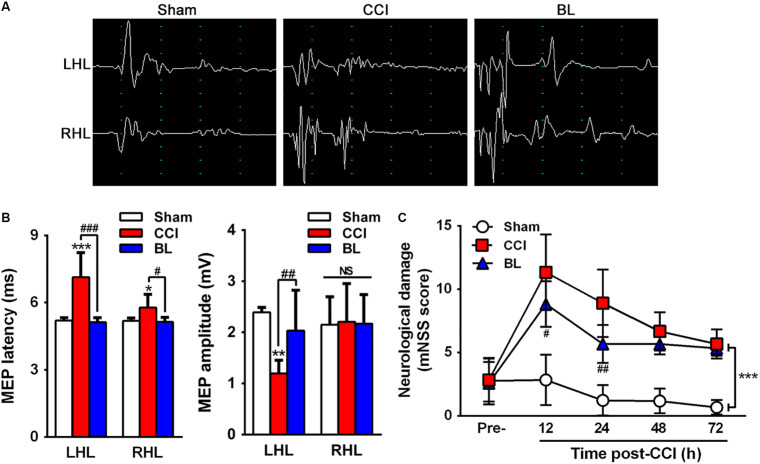
Efficacy of BL-HTWP in neurologic recovery post-TBI. (A) Representative images of motor-evoked potential (MEP). LHL, left hindlimb (CCI-contralateral limb); RHL, right hindlimb (CCI-ipsilateral limb). (B) Alterations of MEP amplitude and latency in the mice of Sham, CCI, and BL at 6 h after CCI. (C) Modified neurological severity (mNSS) score was determined at pre-injury, 12, 24, 48, and 72 h after CCI. Quantitative analysis (n = 12) was conducted by one-way ANOVA. *p < 0.05, **p < 0.01 vs. Sham; #p < 0.05, ##p < 0.01, ###p < 0.001 vs. CCI. NS indicates p > 0.05.